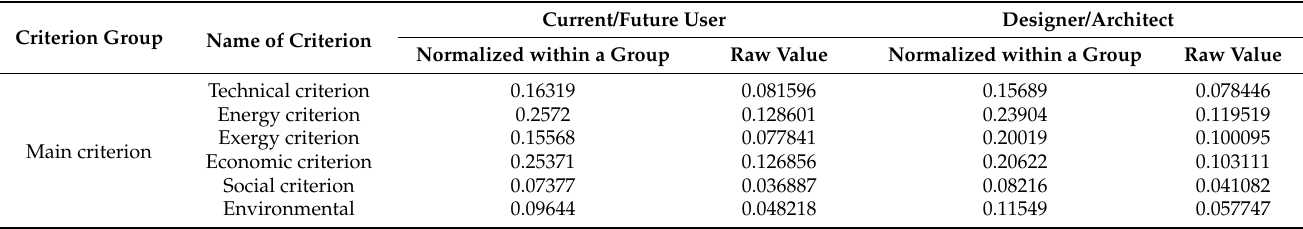
Table 3. Weight vectors for the main evaluation criteria—“Current/Future user” and “Designer/Architect”. Criterion